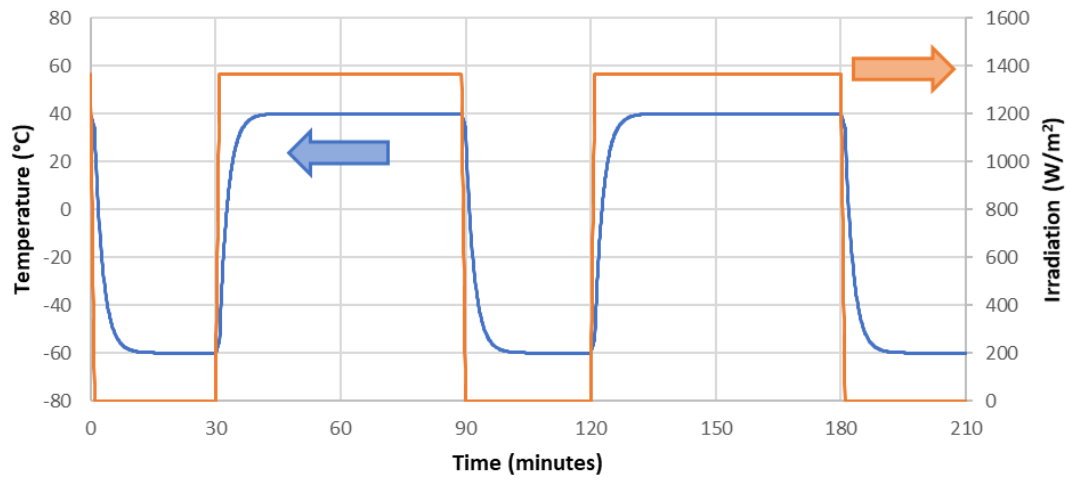
Figure 5. Irradiation (orange curve, right axis) and solar cell temperature (blue curve, left axis) in the considered orbit.